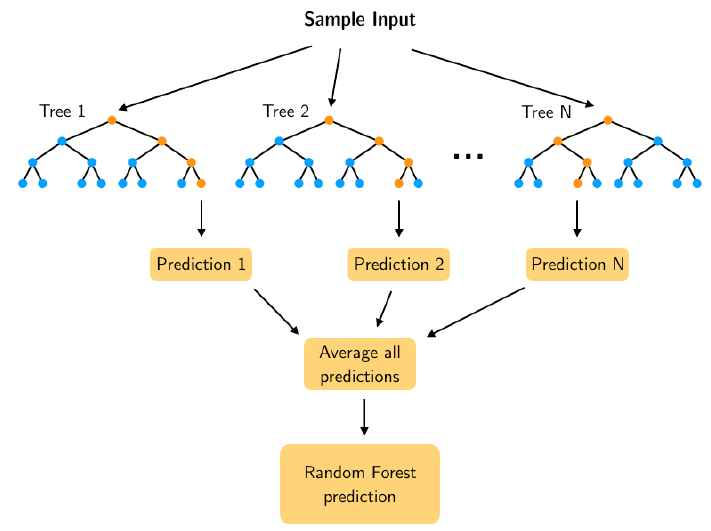
Figure 2. Schematic diagram of random forest model [51].